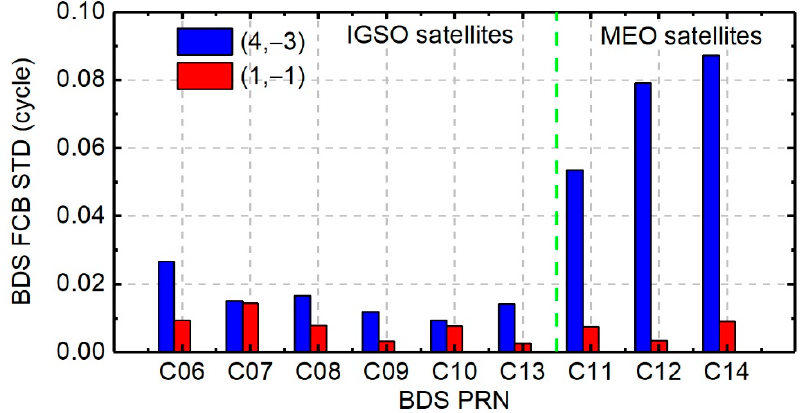
Figure 12. STD of the one day (3 September 2019) BDS-2 FCB time series for each satellite NL and WL combination.